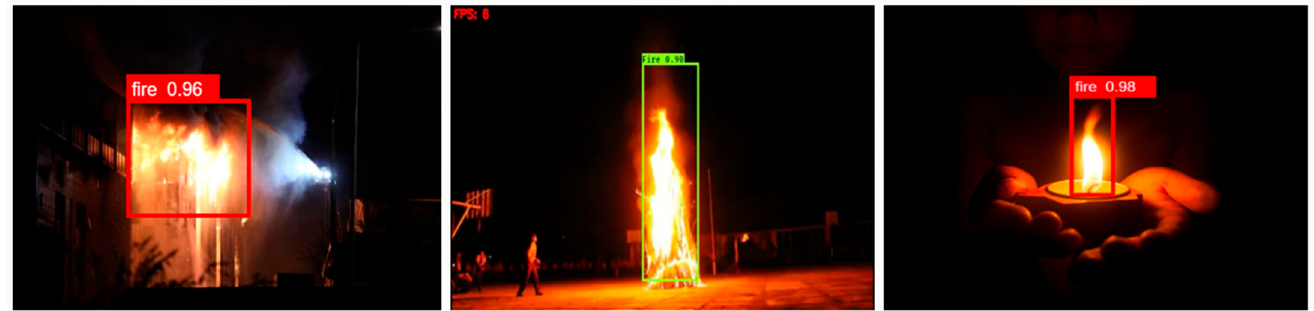
Figure 9. Results of fi re detection system for night images.